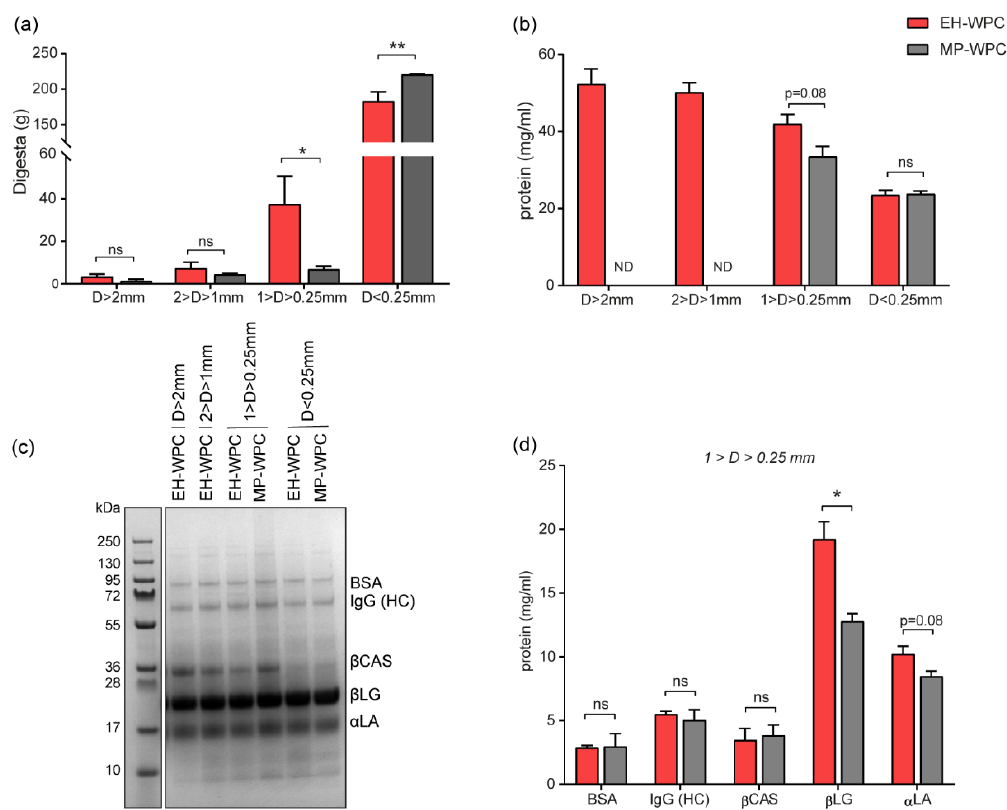
Figure 5. Digestion and coagulation in vitro. ( a ) In vitro digested WPC was separated based on particle size and weight of the separate fractions (g) was recorded. ( b ) Protein concentration of the separated fractions determined by BCA. ( c ) Representative SDS-PAGE gel of digested fractions of EH-WPC and MP-WPC under reducing conditions. ( d ) Protein concentrations calculated based on SDS-PAGE separation for the coagulate with a particle size 1 > D > 0.25 mm. n = 3, ND = not detectable, * p < 0.05, ** p < 0.01, ns = non-significant based on t-test between EH-WPC and MP-WPC. BSA = bovine serum albumin, IgG (HC) = immunoglobulin G (heavy chain), βCAS = β-casein, βLG = β-lactoglobulin, αLA = α-lactalbumin.